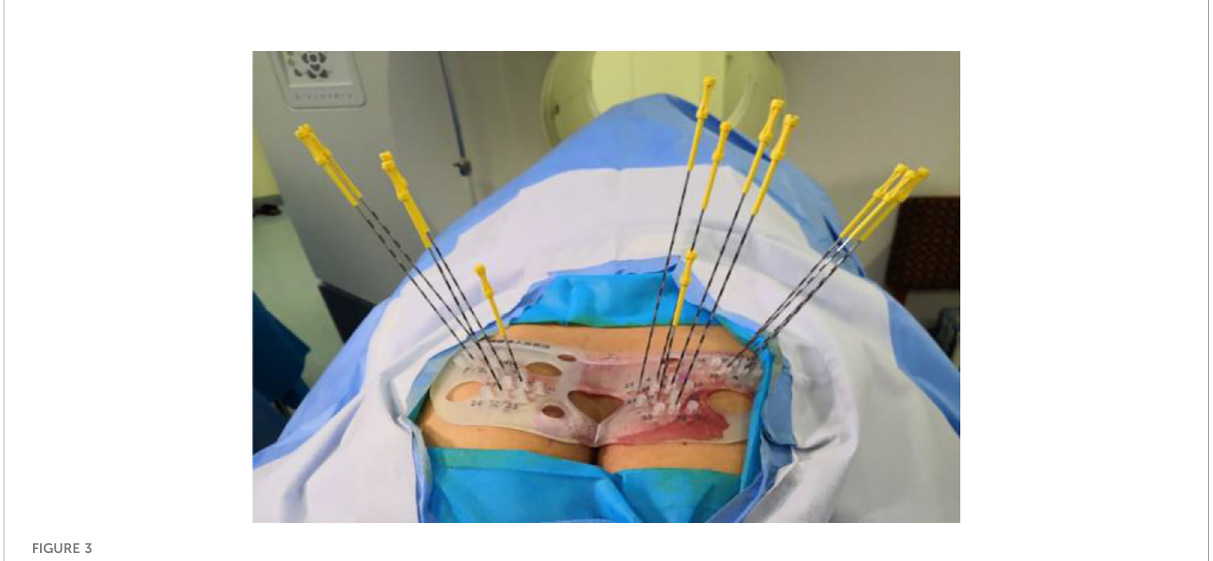
FIGURE 3 Setting of the template and insertion of the particle